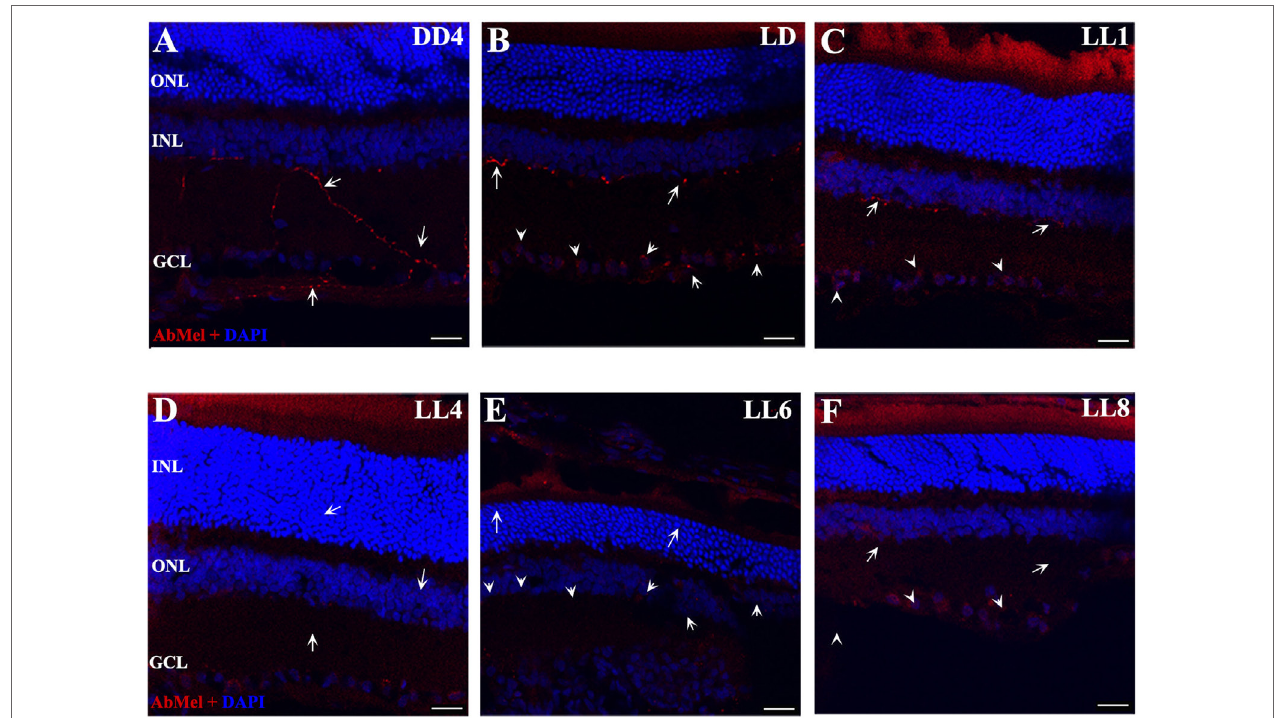
FigUre 3 | OPN4 expression in retinal cuts of animals exposed to light: (a) retinas maintained in dark during 4 days showing positive labeling along the dendrites which extend into INL. (B) Retinas maintained in LD 8 showing a pattern similar to that in DD. (c–F) Light-treated animals during 1, 4, 6, and 8 days in LL showing increasing label restricted to cell soma around nuclear area. Arrow shows the positive labeling of OPN4 in soma, axons, and dendrites. The images are representative of three different experiments per treatment. Red: OPN4 antibody staining; blue: nuclear DAPI staining. Scale bar indicates 30